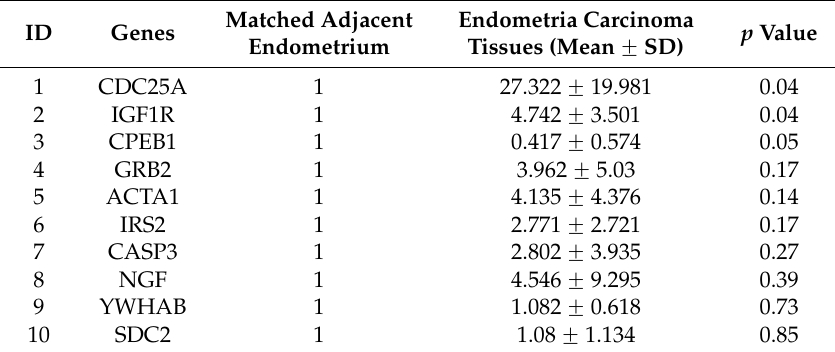
Table 3. qRT-PCR validation of 10 genes with 6 pairs of endometrial carcinoma tissues and matched adjacent normal